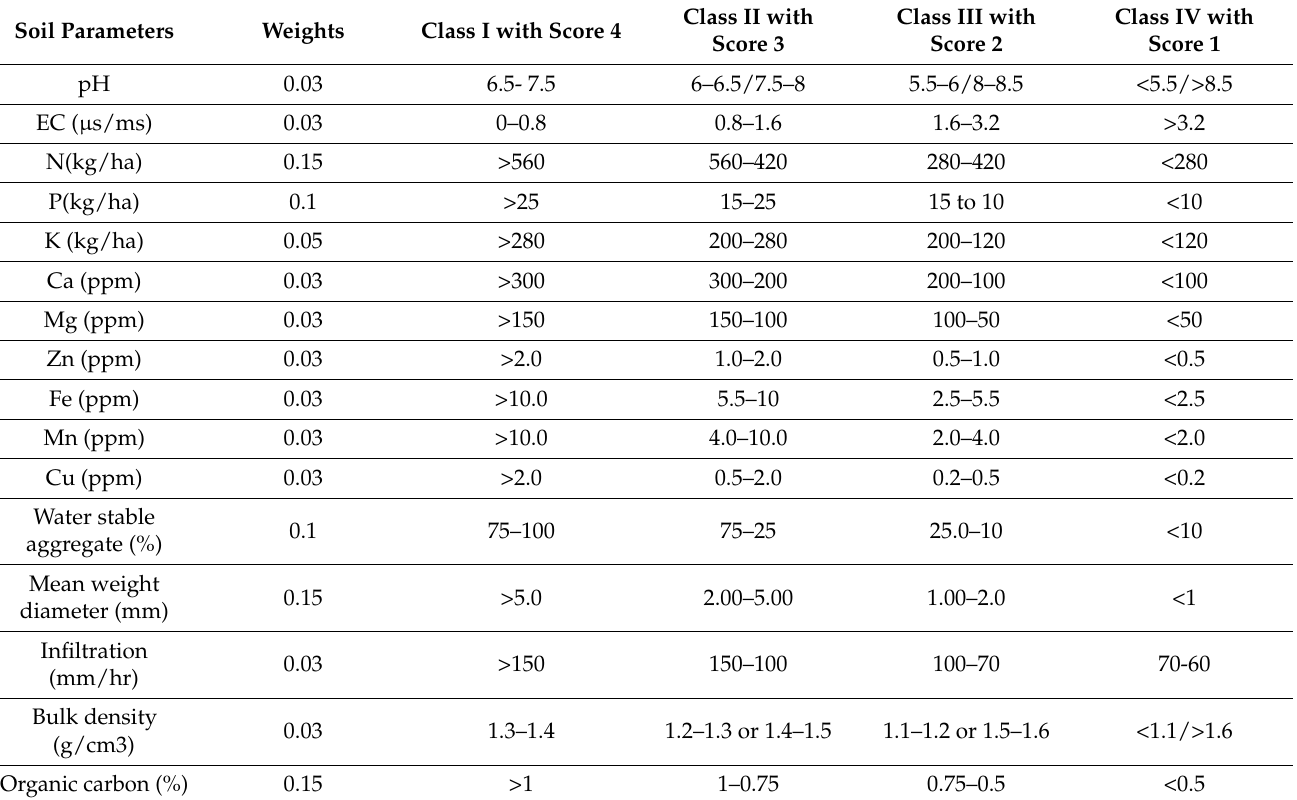
Table 2. The framework of soil parameters and their weights along with scores for assessing the soil quality